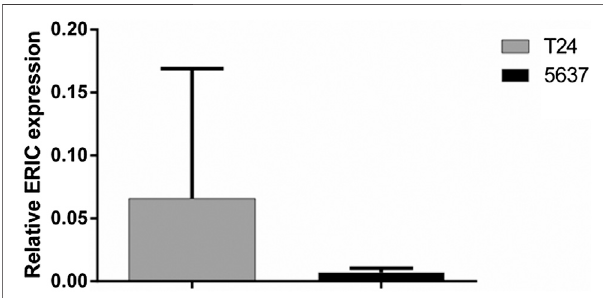
FIGURE4| ExpressionofERICgeneinbladdercancercelllinesT24and 5,637. The relative expression level of ERIC was determined by qRT-PCR assay. The mean value ± SD was